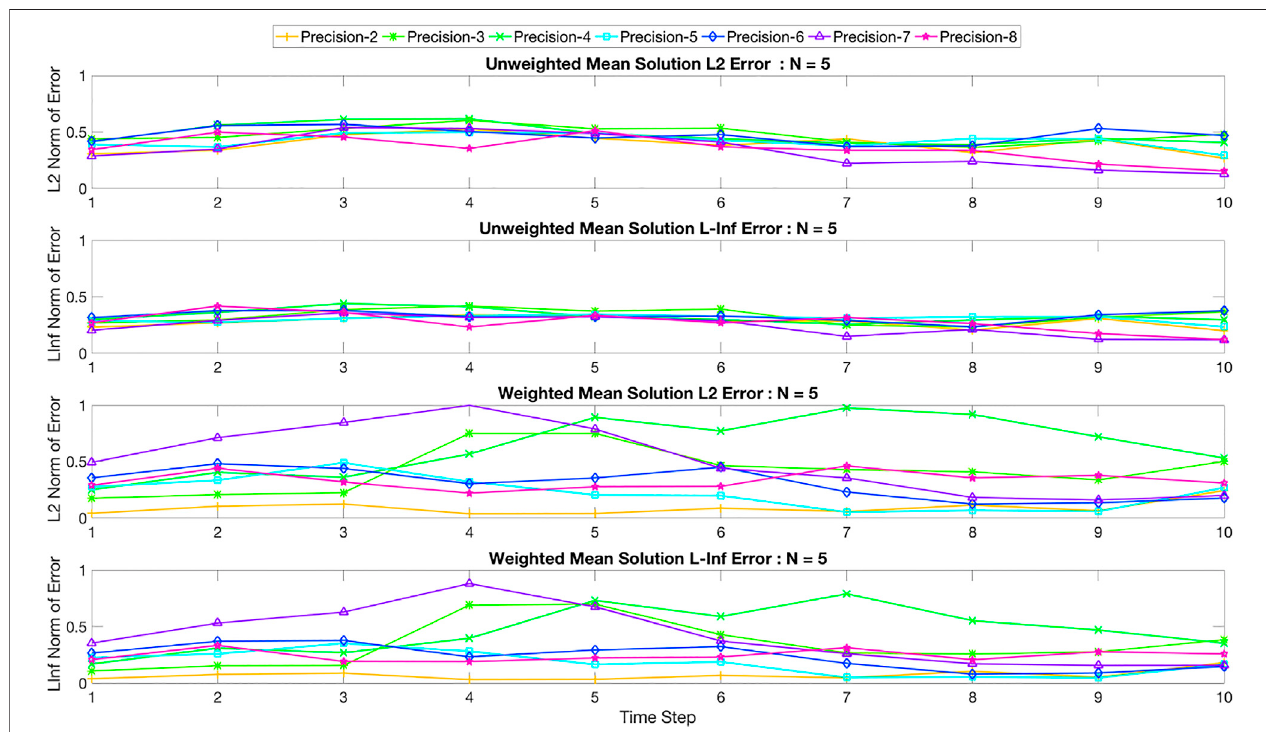
FIGURE 8 | L 2 and L ∞ errors of the unweighted and weighted mean solutions for a problem with fi ve grid points. The precision varies from 2 to 8 and the error is computed for each time step.